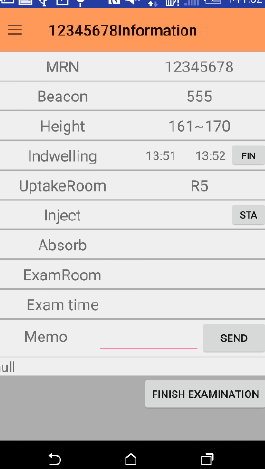
Figure 13. Interface for indwelling needle and injection phase.